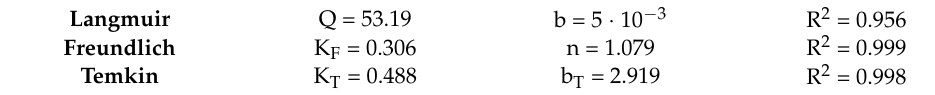
Table 3. Isotherm adsorption parameters for the different models.